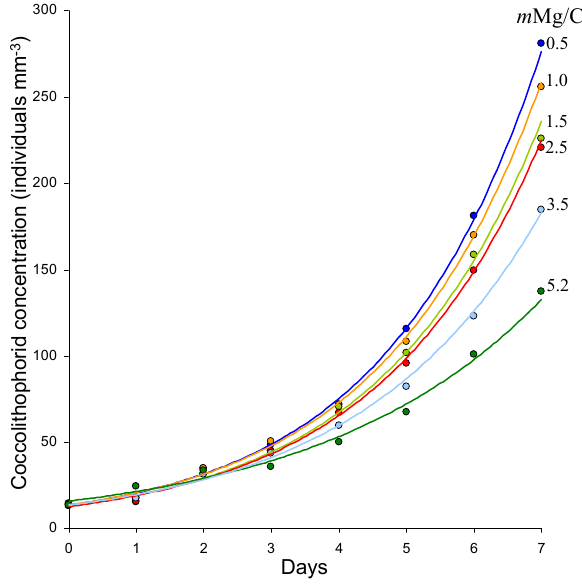
050100150200250300 0 Fig. 11. Exponential population growth for the coccolithophore Pleurochrysis carterae as a function of seawater Mg/Ca. Rates of population growth increased significantly ( p < 0 . 05) as seawater Mg/Ca declined into the calcite stability field, which favors precipi- tation of the coccolithophores’ calcite skeletal mineral. For modern seawater, Mg/Ca is 5.2 and the absolute concentration of Ca 2 + is 10mmolkg-SW − 1 ; for the imputed Late Cretaceous seawater, the Mg/Ca ratio is between 0.5 and 1.5 and the absolute concentration of Ca 2 + is between 42 and 25mmolkg-SW − 1 . R 2 is between 0.98 and 0.99 for exponential fitted curves. Spearman rank correlation ( r s ) =0.99 for growth rates. From Stanley et al.